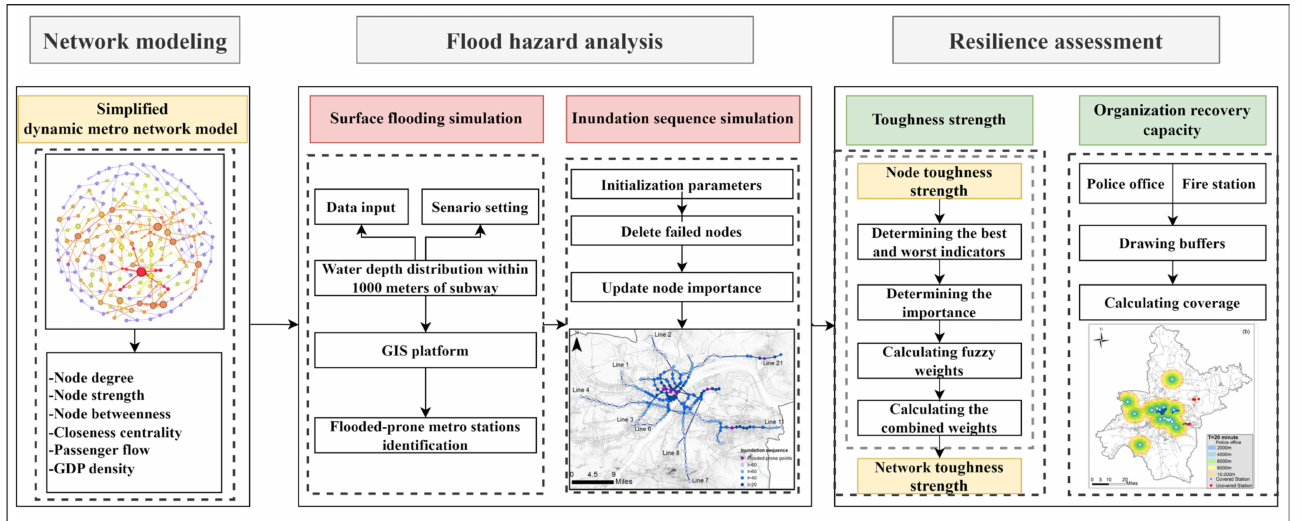
Figure 2. The framework of